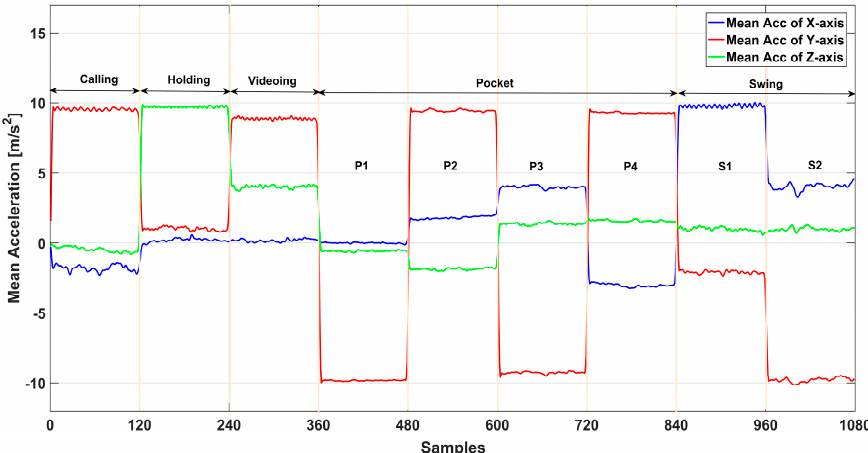
Figure 4. Average acceleration in di ff erent modes. In the pocket mode, P1 and P3 represent the cases in which the phone screen was pointed to the user’s body and the direction of movement, respectively, during which the phone was placed upside down in the pocket; P2 and P4 represent the cases in which the phone screen was pointed to user’s body and in the direction of movement, respectively, during which the phone approximately points upwards. In the swing mode, S1 and S2 represent the case in which the phone approximately points to the direction of pedestrian motion and the ground, respectively.